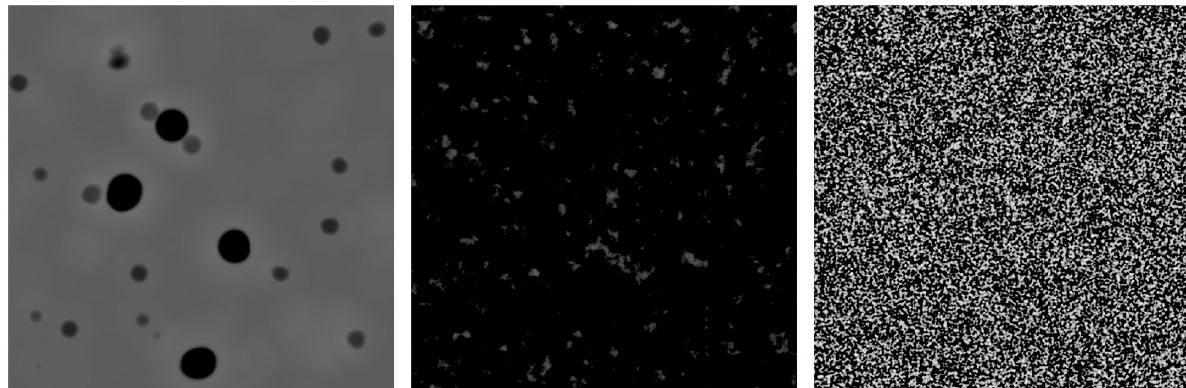
Fig 3. Procedurally generated height maps. For craters (left), rocks (centre) and sand (right).